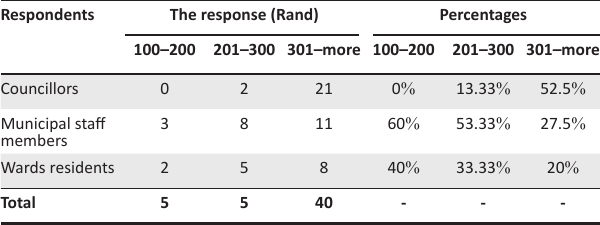
TABLE 3: Summary of the respondents on their monthly expense for municipal services.